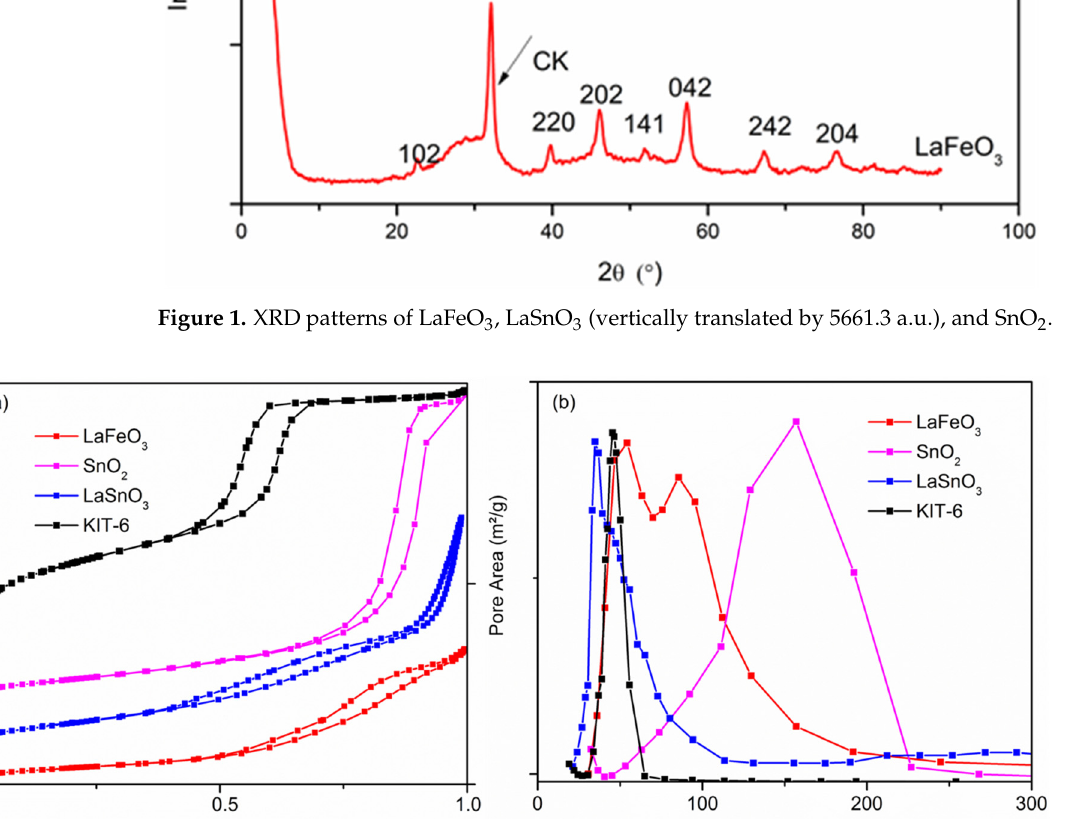
Figure 1. XRD patterns of LaFeO 3 , LaSnO 3 (vertically translated by 5661.3 a.u.), and SnO 2 .